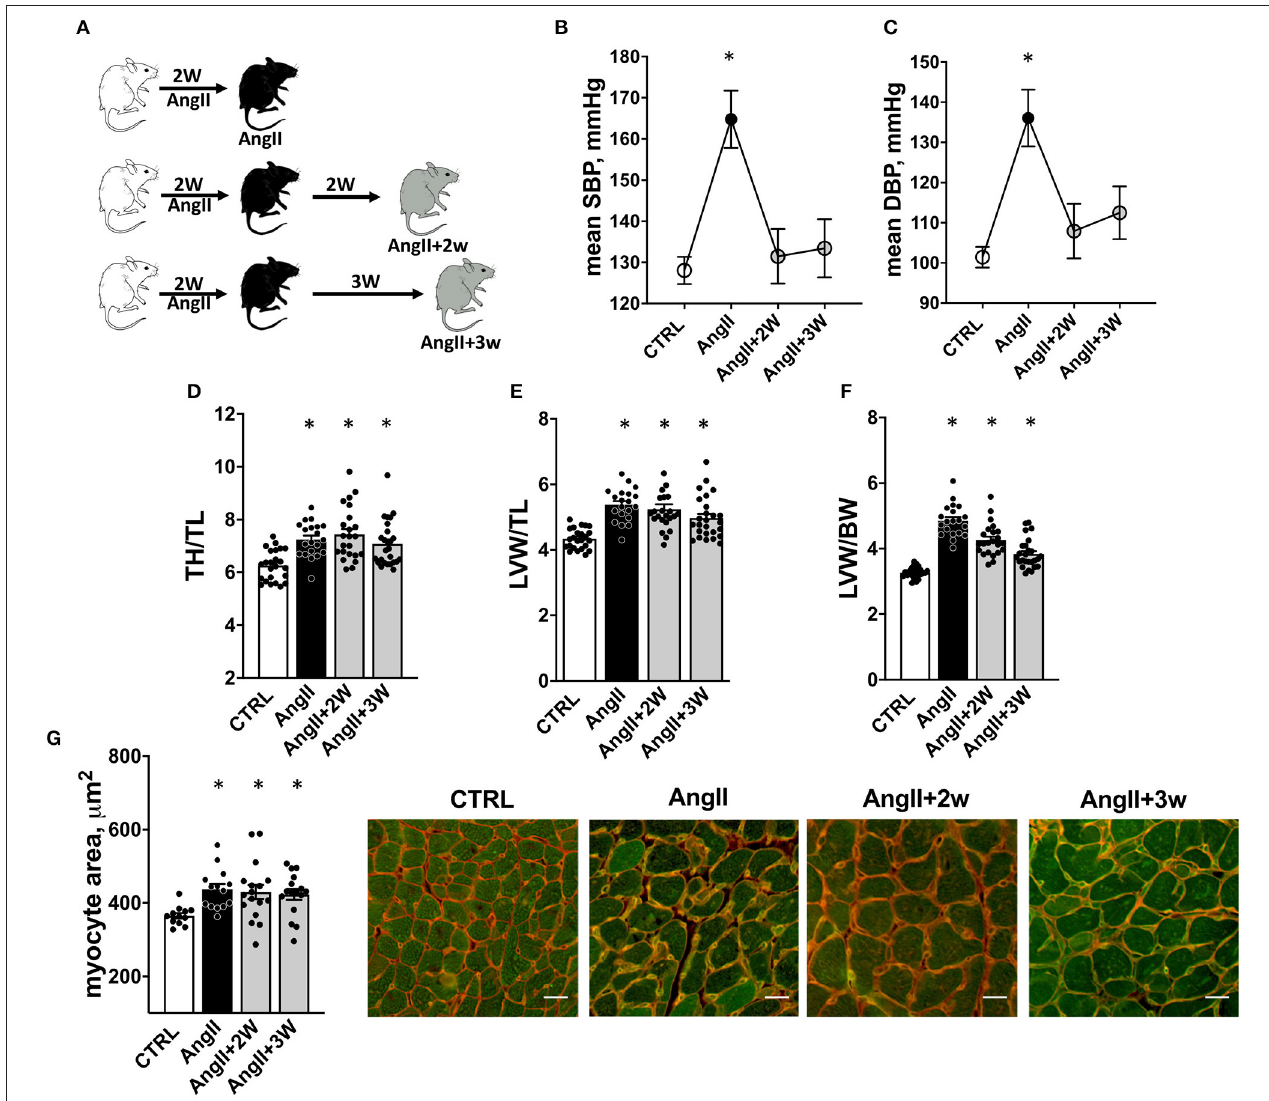
FIGURE 1 | Experimental procedure and cardiac hypertrophy. Experimental procedure: (A) C57Bl6 mice were implanted with osmotic minipump delivering 2.8mg/kg/d of AngII during 2 weeks. One group was sacrificed at the end of the treatment ( AngII ), 2 others were sacrificed, respectively, 2 weeks ( AngII + 2W ) and 3 weeks ( AngII + 3W ) after the end of the minipump, and were considered as “memory groups”. Control mice ( CTRL ) were littermate age-matched mice sacrificed at each time point (2 weeks of AngII, 2 weeks of AngII + 2 weeks, 2 weeks of AngII + 3 weeks). (B) Systolic and (C) Diastolic blood pressure measured with implanted telemetry devices. n = 19; * p < 0.05, one-way ANOVA for repeated measures, mixed-effect analysis followed by Tukey’s multiple comparison test. (D–G) Cardiac Hypertrophy: (D) Total heart/tibial length ratio (TH/TL); (E) Left ventricular weight/tibial length ratio (LVW/TL); and (F) Left ventricular weight/body weight ratio (LVW/BW). n = 93 (initial + replication cohorts); * p < 0.05, one-way ANOVA followed by Holm-Sidak’s multiple comparisons test. (G ) Quantification of myocyte size area by isolectin/WGA staining and representative pictures (white bar scale = 20 µ m). n = 59; * p < 0.05, one-way ANOVA followed by Dunett’s multiple comparisons